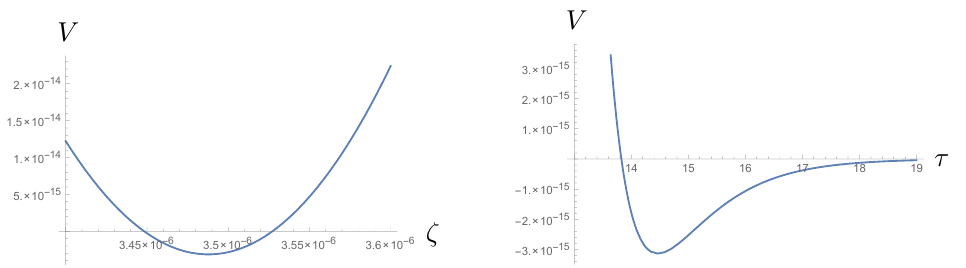
Figure 4 . Left: V ( (cid:16); (cid:28) ) for (cid:28) = 14 : 47, Right: V ( (cid:16); (cid:28) ) for (cid:16) = 3 : 49 (cid:1) 10 (cid:0) 6 , both cases for (cid:27) = 0, (cid:18) = (cid:0) (cid:25)= 2 and the choice of parameters: M = 10, K = 10, g s = 1 = 2, A = a = 1. so their ratio